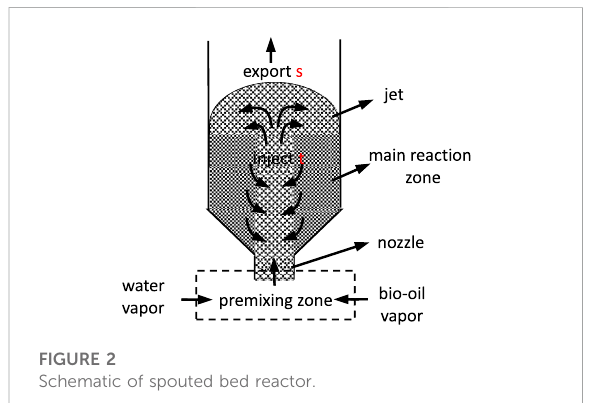
FIGURE 2 Schematic of spouted bed